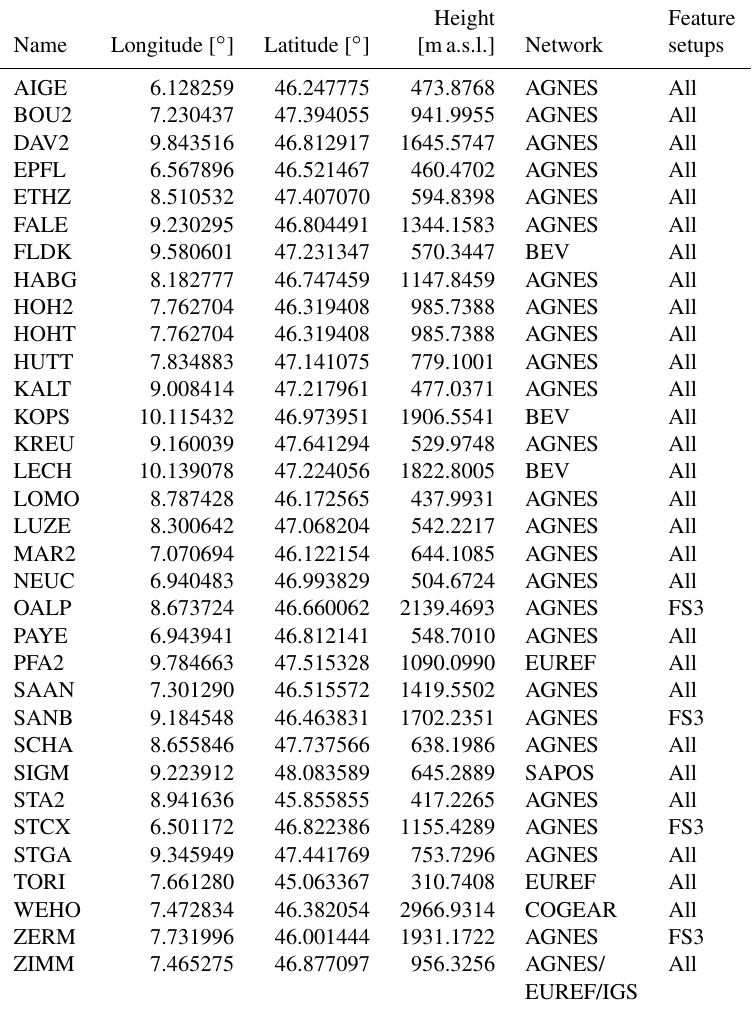
Table A1. Full list of GNSS stations utilised for this study. Indicated are Name, geographical location (Longitude, Latitude and Height), Network to which a station belongs, and the Feature setup in which it is